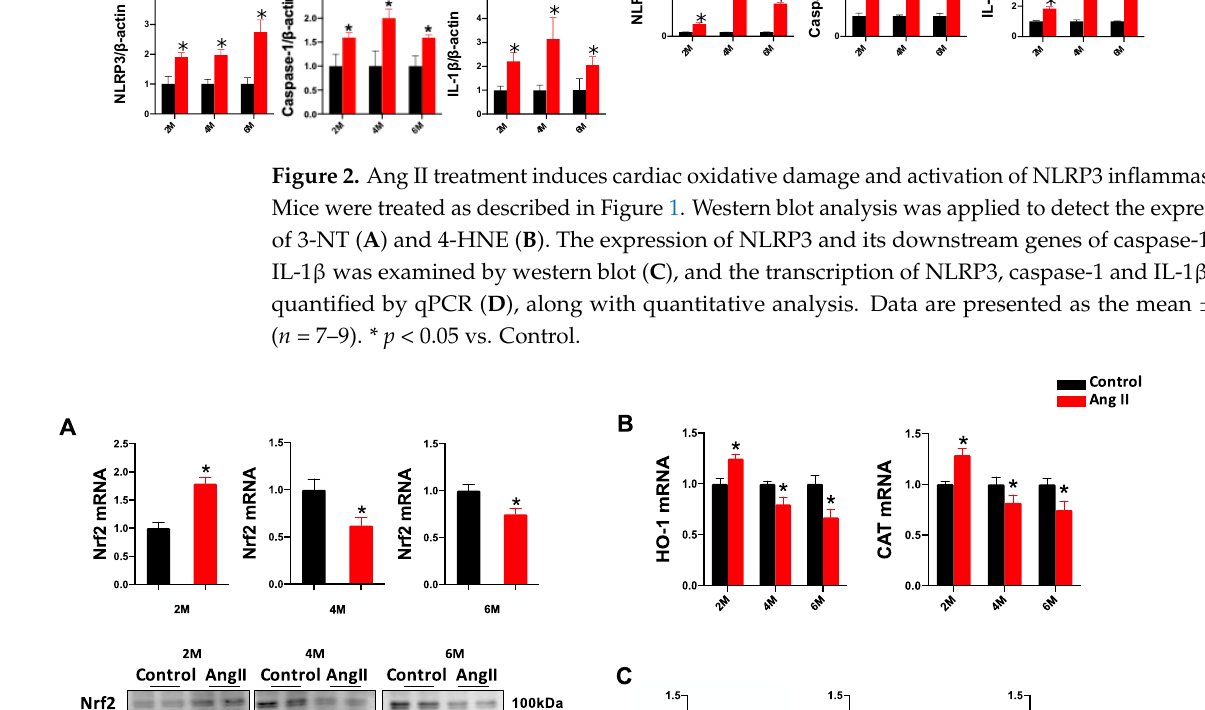
Figure 2. Ang II treatment induces cardiac oxidative damage and activation of NLRP3 inflam- masome. Mice were treated as described in Figure 1. Western blot analysis was applied to detect the expression of 3-NT ( A ) and 4-HNE ( B ). The expression of NLRP3 and its downstream genes of caspase-1 and IL- 1β was examined by western blot ( C ), and the transcription of NLRP3, caspase-1 and IL- 1β was quantified by qPCR ( D ), along with quantitative analysis. Data are presented as the mean ± SD ( n = 7 – 9). * p < 0.05 vs. Control.